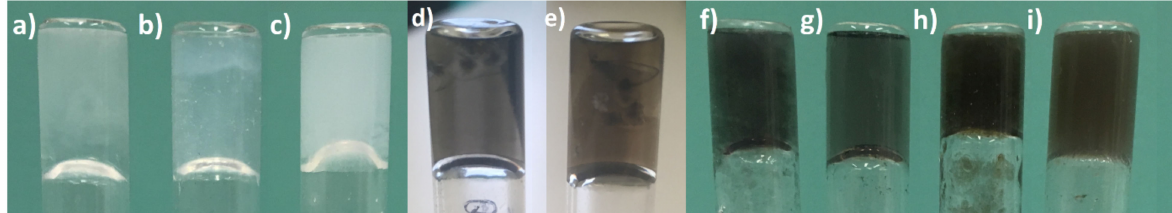
Figure 3. Photographs of the hydrogels obtained by applying the pH-switch method. ( a ) Boc- α ( S )Phe- α ( S )Phe-OH, ( b ) Boc- β 3 ( R )Phe- β 3 ( R )Phe-OH, ( c ) Boc- γ 4 ( R )Phe- γ 4 ( R )Phe-OH, ( d ) Boc- α ( S )Phe- α ( S )Phe-OH + 0.025 wt% ox-CNTs, ( e ) Boc- α ( S )Phe- α ( S )Phe-OH + 0.025 wt% GO, ( f ) Boc- β 3 ( R )Phe- β 3 ( R )Phe-OH + 0.025 wt% ox-CNTs, ( g ) Boc- γ 4 ( R )Phe- γ 4 ( R )Phe-OH + 0.025 wt% ox-CNTs, ( h ) Boc- β 3 ( R )Phe- β 3 ( R )Phe-OH + 0.025 wt% GO, and ( i ) Boc- γ 4 ( R )Phe- γ 4 ( R )Phe-OH + 0.025 wt%